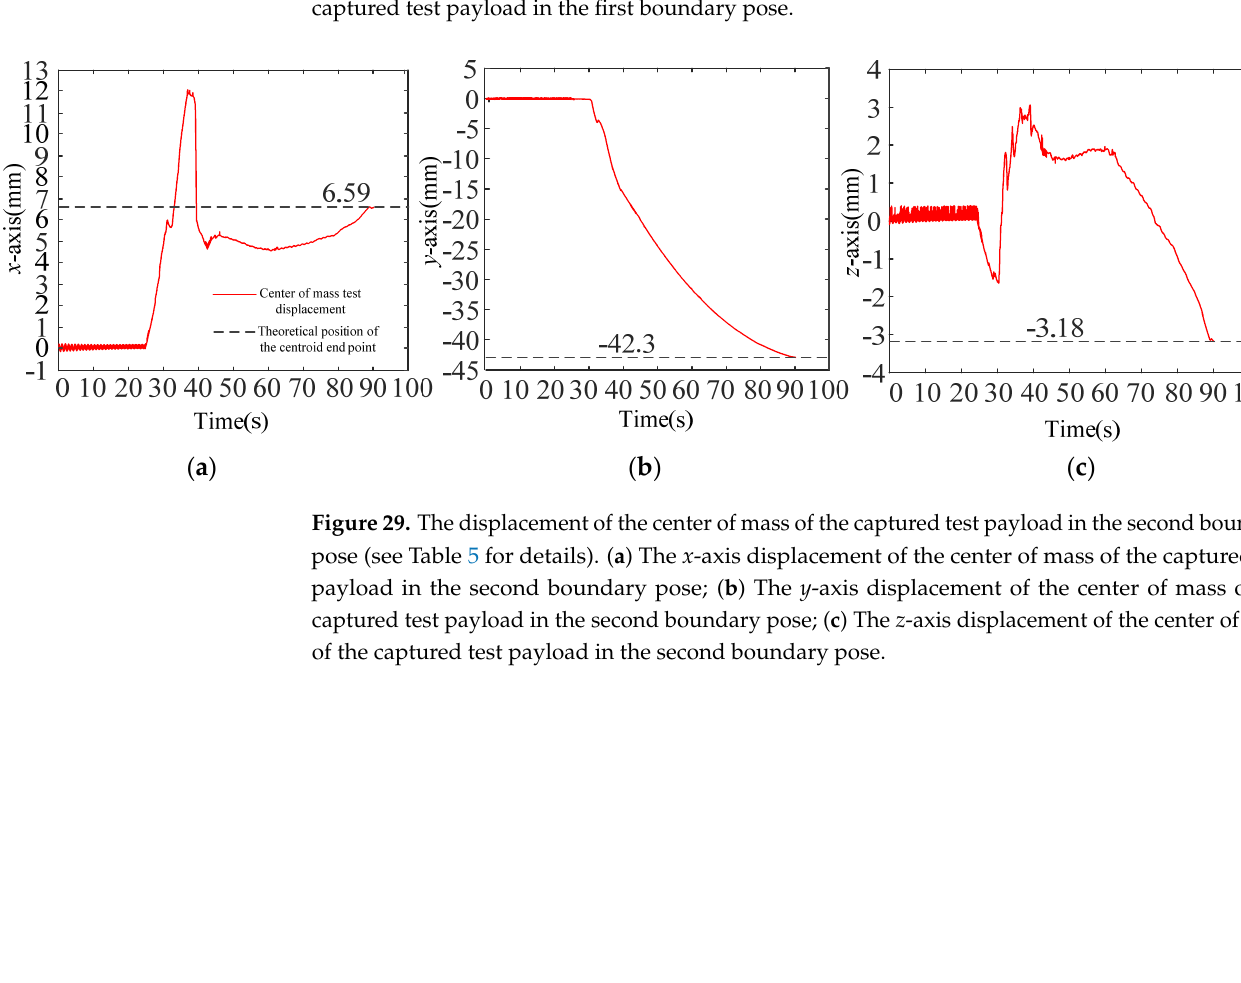
Figure 30. The displacement of the center of mass of the captured test payload in the third boundary pose (see Table 5 for details). ( a ) The x -axis displacement of the center of mass of the captured test payload in the third boundary pose; ( b ) The y -axis displacement of the center of mass of the captured